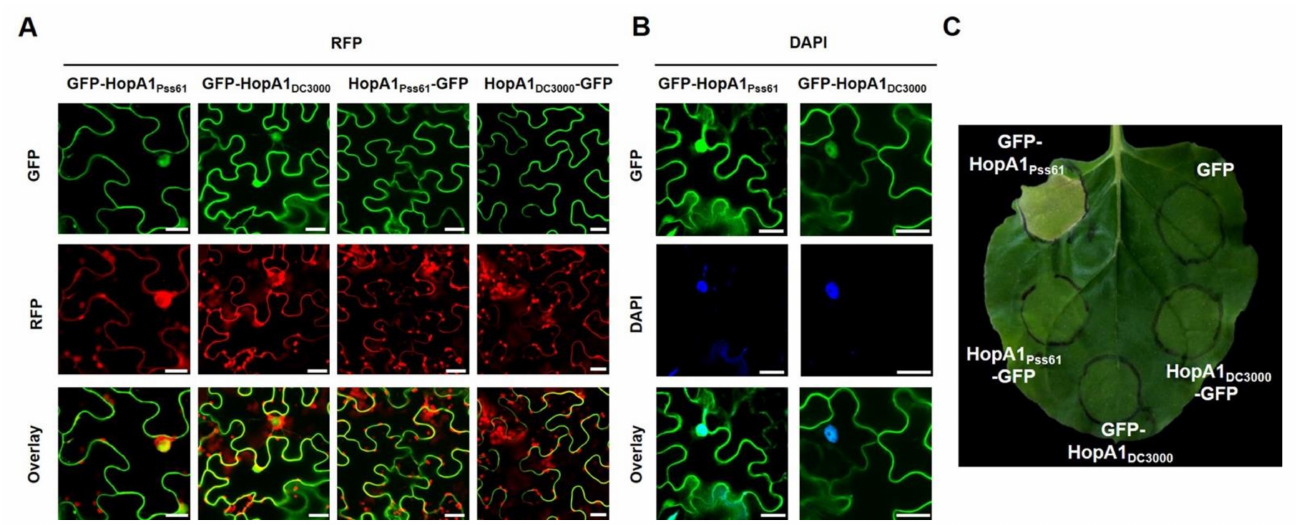
Figure 2. GFP- HopA1 Pss61 , but not HopA1 Pss61 -GFP, targets to the nucleus and induces cell death. ( A ) GFP-hopA1 Pss61 , hopA1 Pss61- GFP , GFP-hopA1 DC3000 , and hopA1 DC3000- GFP fusion constructs (from left to right) were transiently expressed